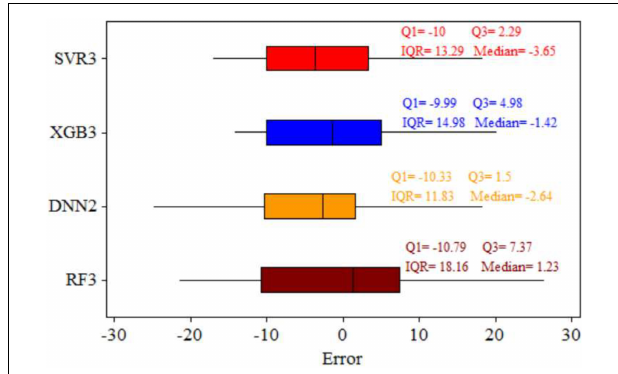
FIGURE 5 | Boxplots showing the distribution of the estimation errors in the test stage for support vector regressor (SVR), extreme gradient boosting (XGB), deep neural network (DNN), and random forest (RF) models. Q25, lower quartile of errors; Q75, upper quartile of errors; IQR, interquartile range for each model.